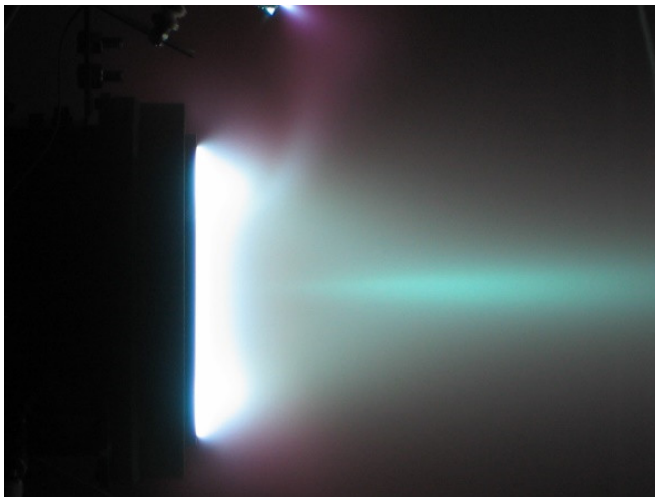
Figure 1. Pratt & Whitney T-140 Hall thruster operating with xenon propellant.